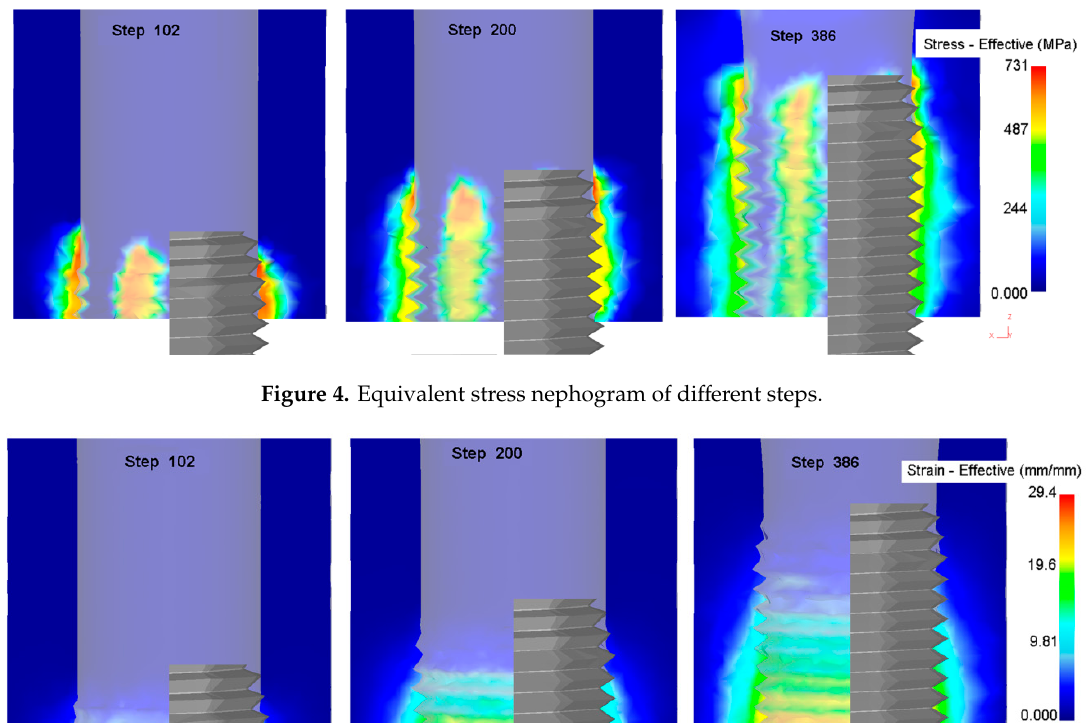
Figure 7. Velocity profile of each point on the thread surface. 3.1.3. Influence of the Hole Diameter When extruding the internal thread with the extrusion tap, the area where the diameter of magnesium alloy workpiece material is larger than the diameter of the hole flows to the area with the smaller diameter, and the diameter of the guide hole significantly affects the shape of thread, thus affecting the torque in the process of thread formation [16]. During the simulation and experiment, the rotating speed of the machine tool was 100 rpm, the auxiliary heating temperature was 573 K, and the diameter of the hole was set to 11.40, 11.42, 11.45, 11.47 and 11.50 mm, respectively. The torque simulation value and torque test value were compared. Figure 8 shows the change of torque under different hole diameters. With an increase in hole diameter, the torque gradually decreased. When the hole diameter changed from Φ 11.40 to Φ 11.45 mm, the effect of this reduction was more obvious.